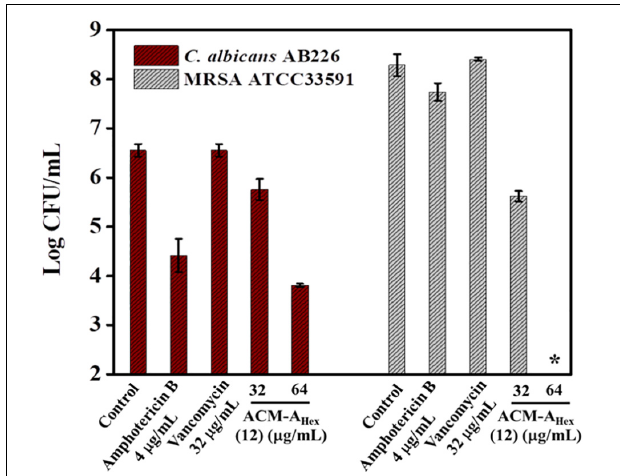
FIGURE 6 | Quantification of microbial cells embedded within Polymicrobial biofilm of C. albicans AB226 and MRSA ATCC33591. (Asterisks corresponds to < 50 CFU/mL). Each value represents average of two different experimental values and error bar indicates standard deviation ( p < 0.0001, two-way